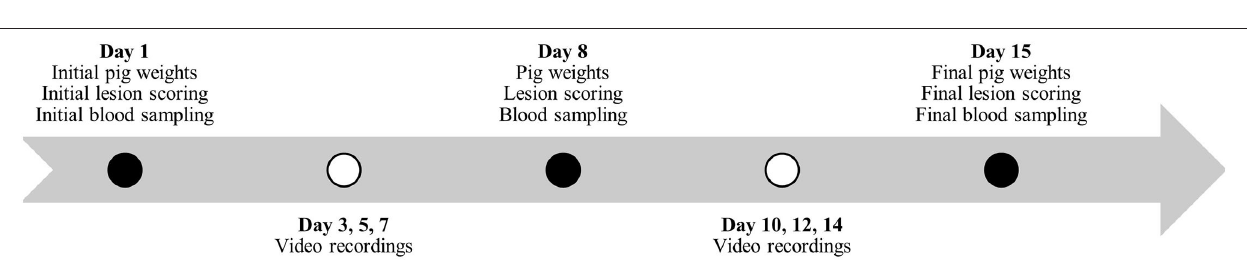
FIGURE 2 | Timeline during study #2 for pig weights, lesion scoring, blood sampling and behavior video